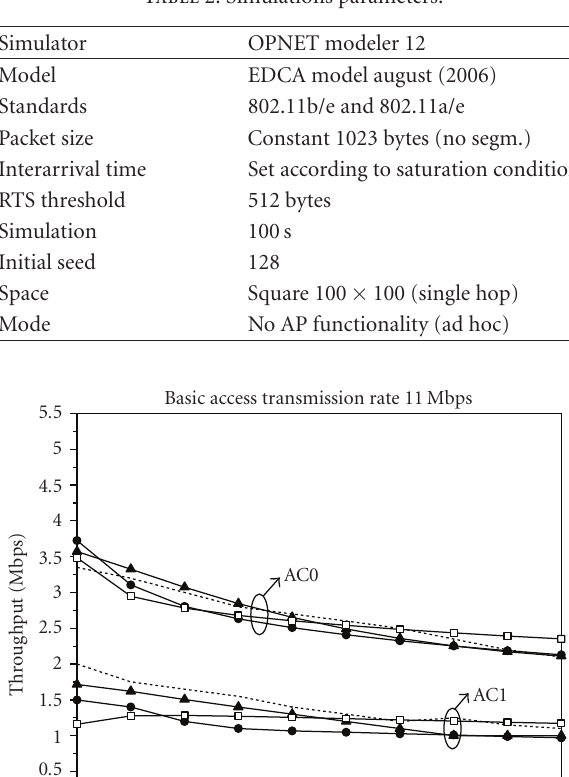
Table 2: Simulations parameters.